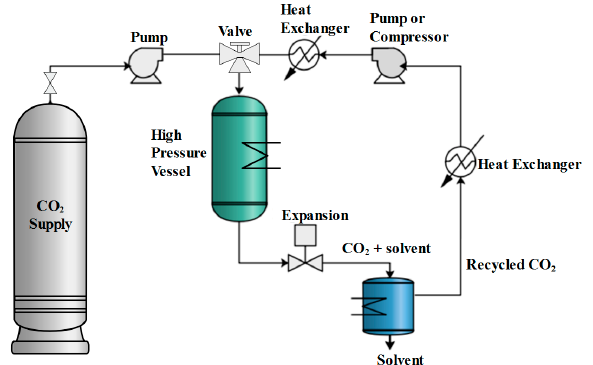
Figure 5. Flowsheet of a supercritical CO 2 drying cycle.